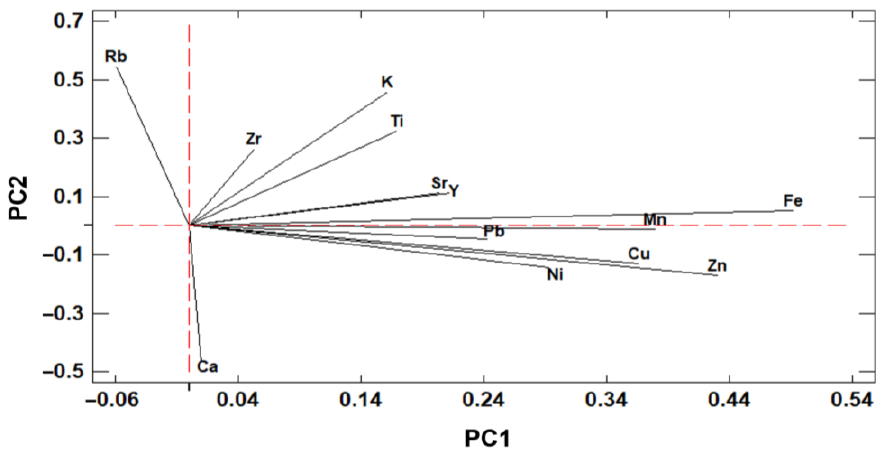
Figure 2. First two components of the principal component analysis of the outdoor samples.